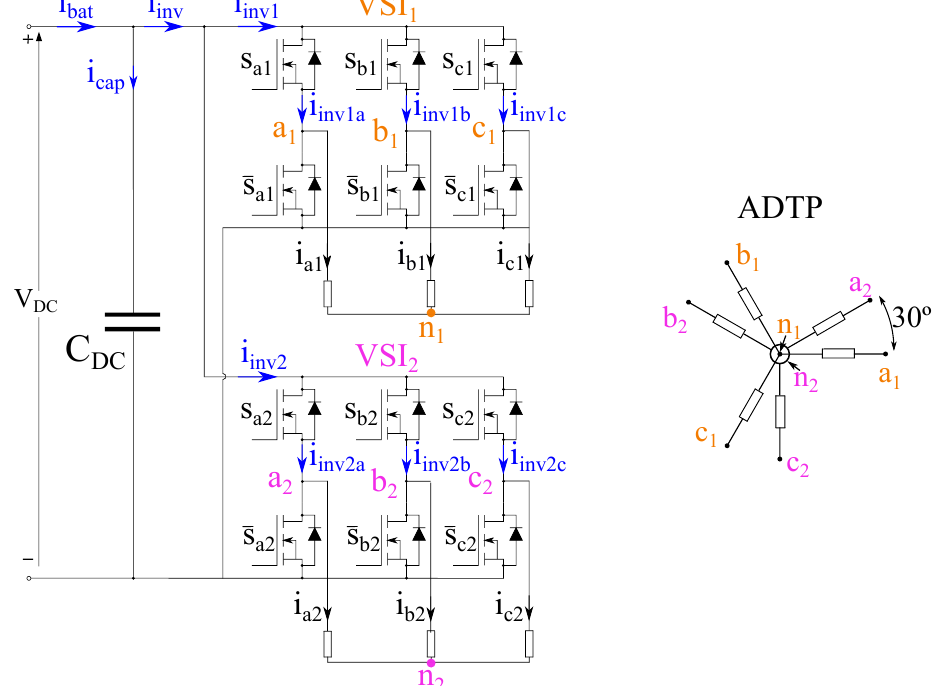
Figure 1. Asymmetric dual three-phase electric machine with two parallel three-phase VSIs. Thus, ADTP-specific voltage-source inverters (VSIs) have been developed, which show great potential in safety-critical applications, and when high power density is needed, such as in electric vehicle (EV) drivetrains [19]. These VSIs (Figure 1) can be controlled by using either appropriate space vector (SV) [20–24] or carrier-based (CB) [25–30] PWM techniques. There is a wide variety of SV-PWM techniques for the ADTP topology; some of them utilize two large adjacent active vectors to synthesize the reference voltage vector [20], and others use four large active vectors [20,21], three large active vectors plus one medium active vector [22], or two large and two medium active vectors [23]. In contrast, CB-PWM strategies are usually treated as a dual three-phase structure (VSI 1 and VSI 2 , Figure 1), in- conventional CB-PWM techniques can be exploited. Figure 2 shows how these three-phase CB-PWM techniques are implemented, where v ∗ = M cos ( θ 1 ) is the modulating signal, v 0 s θ 1 is the modulating signal’s angular position and the modulation index ( M ) is defined as M = ˆ V 1 / ( 0.5 · V [31], where ˆ V 1 is the peak phase-neutral voltage and V DC is the DC-Link DC ) voltage (Figure